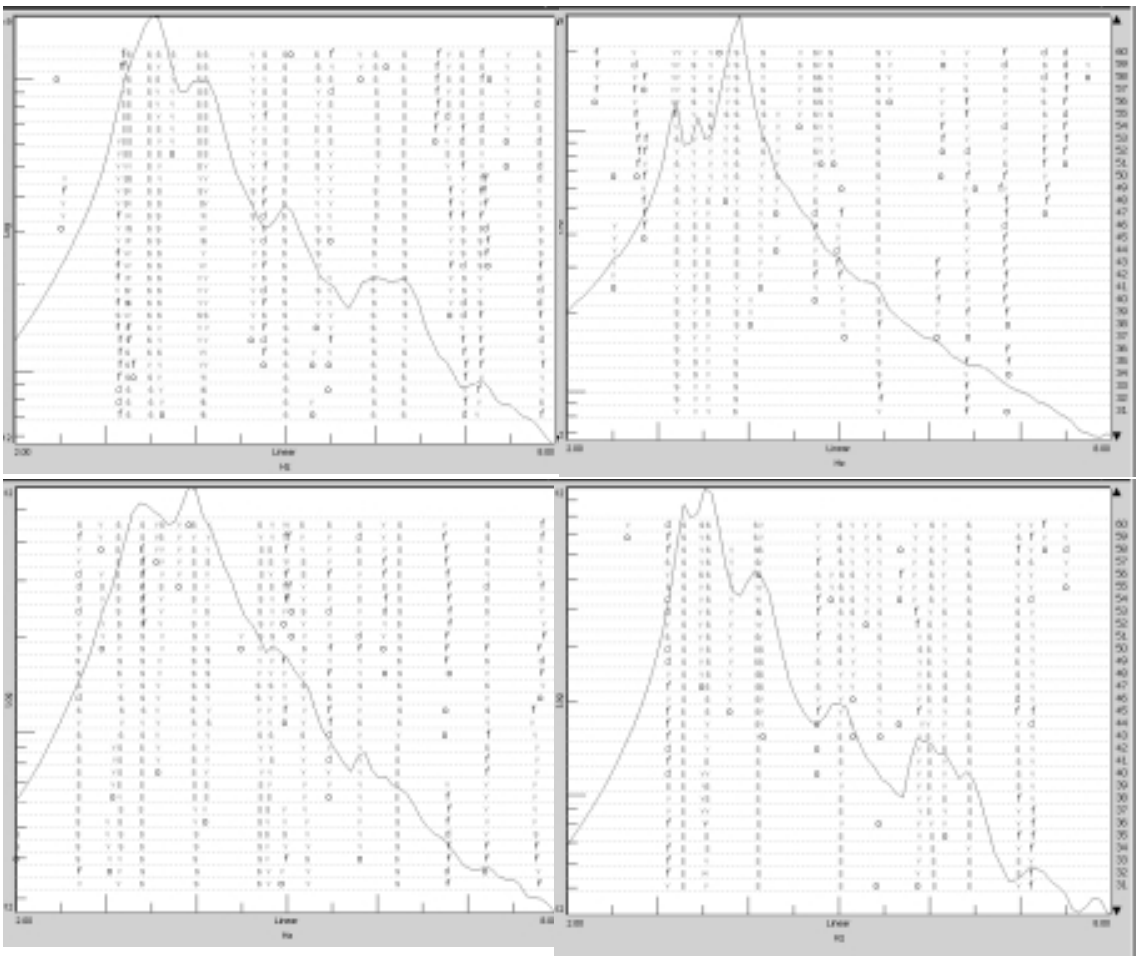
Fig. 13. PolyMAX stabilisation diagrams for different events: Filling – 1 st goal – sitting –